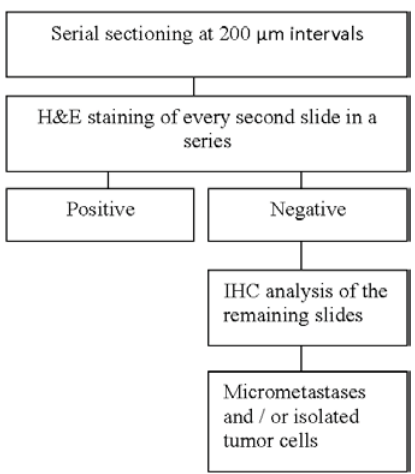
Figure 1. The protocol of histopathological examination of the SLN and